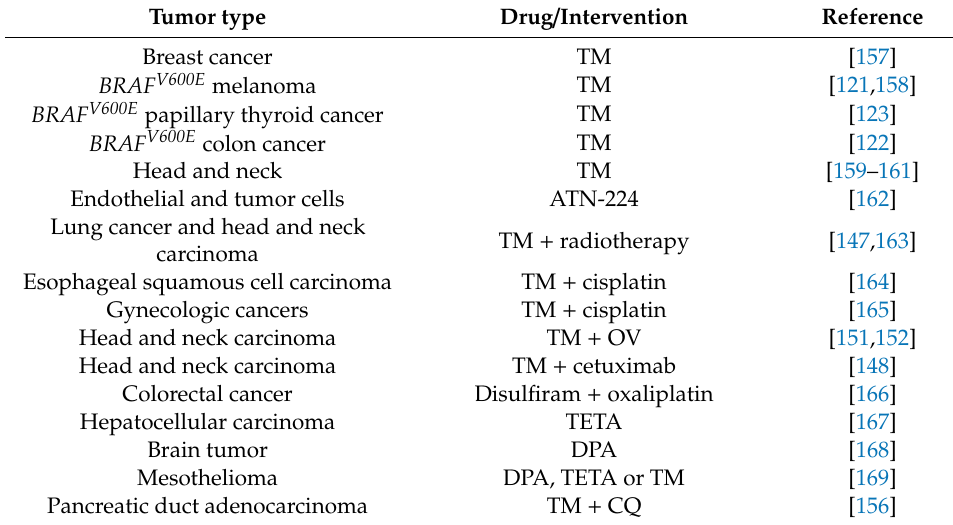
Table 3. Major preclinical studies on copper chelation therapy for